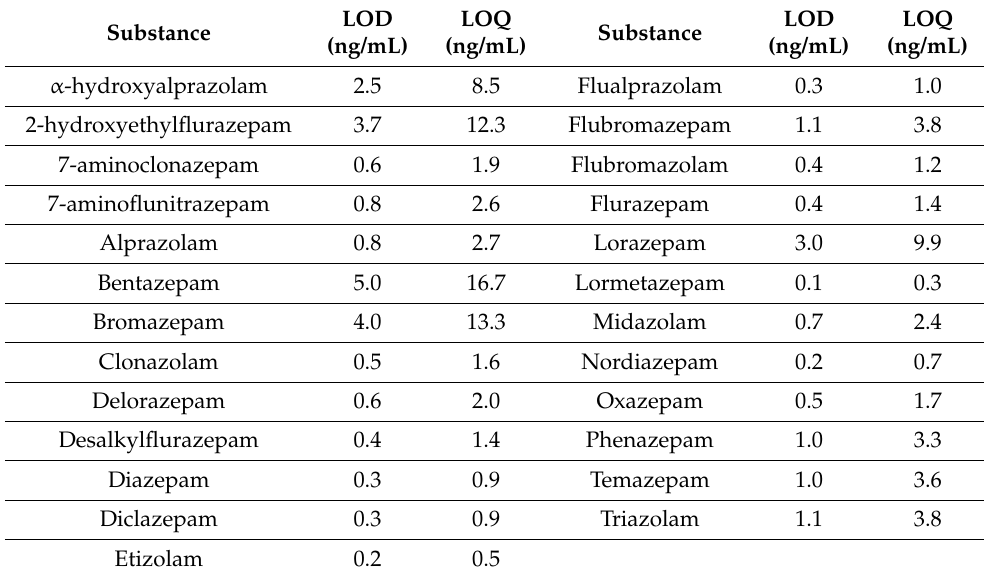
Table 4. LODs and LOQs of the monitored substances by LC-MS/MS